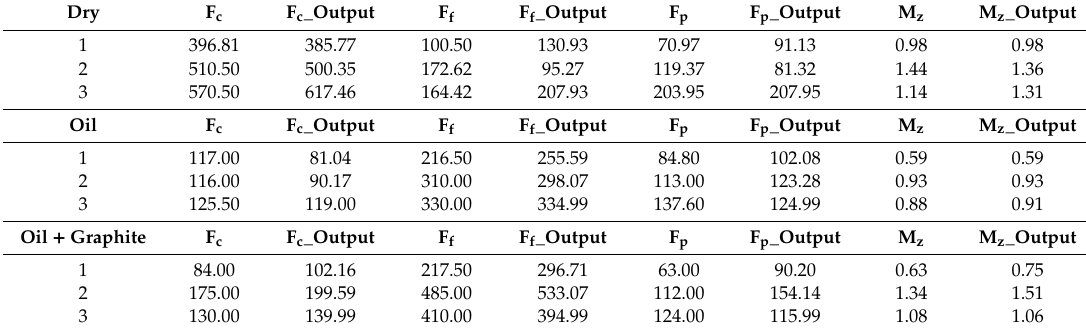
Table 13. Custom predictions—Forces and torque.